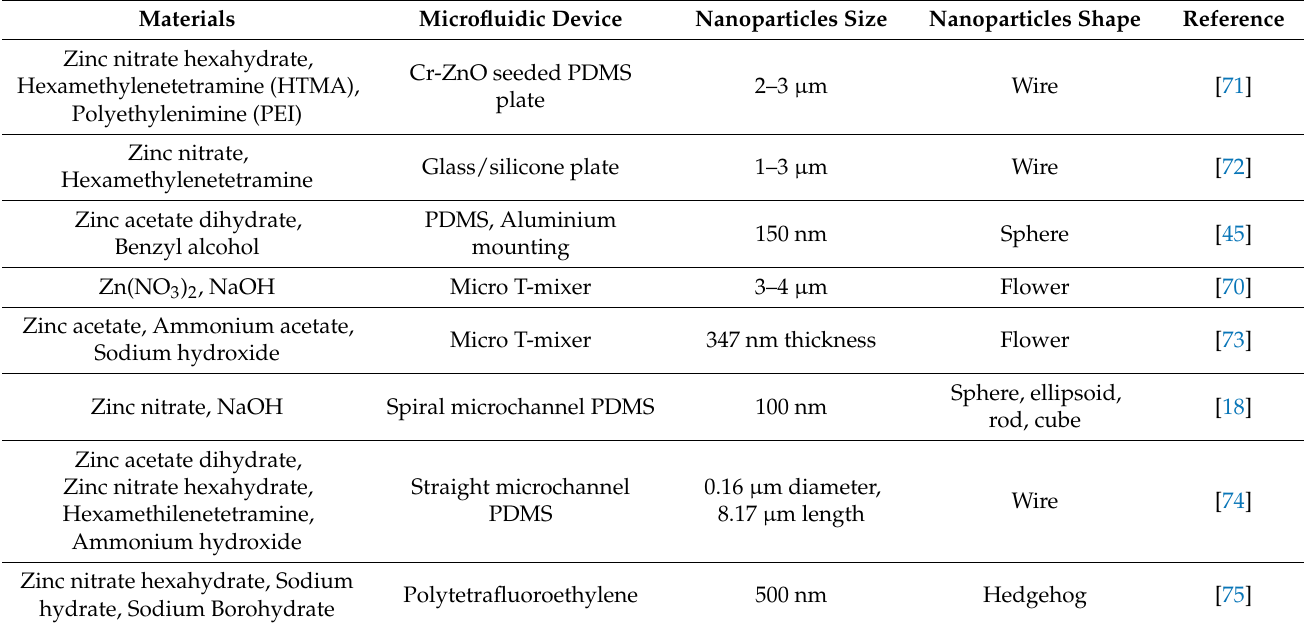
Figure 17. SEM micrographs of ( a ) spherical ZnO NPs, ( b ) flower-like ZnO NPs, and ( c ) ZnO Nanowires. Reprinted with permission from [70]. Copyright (2014) American Chemical Society. Table 2. Synthesis of ZnO nanoparticles via